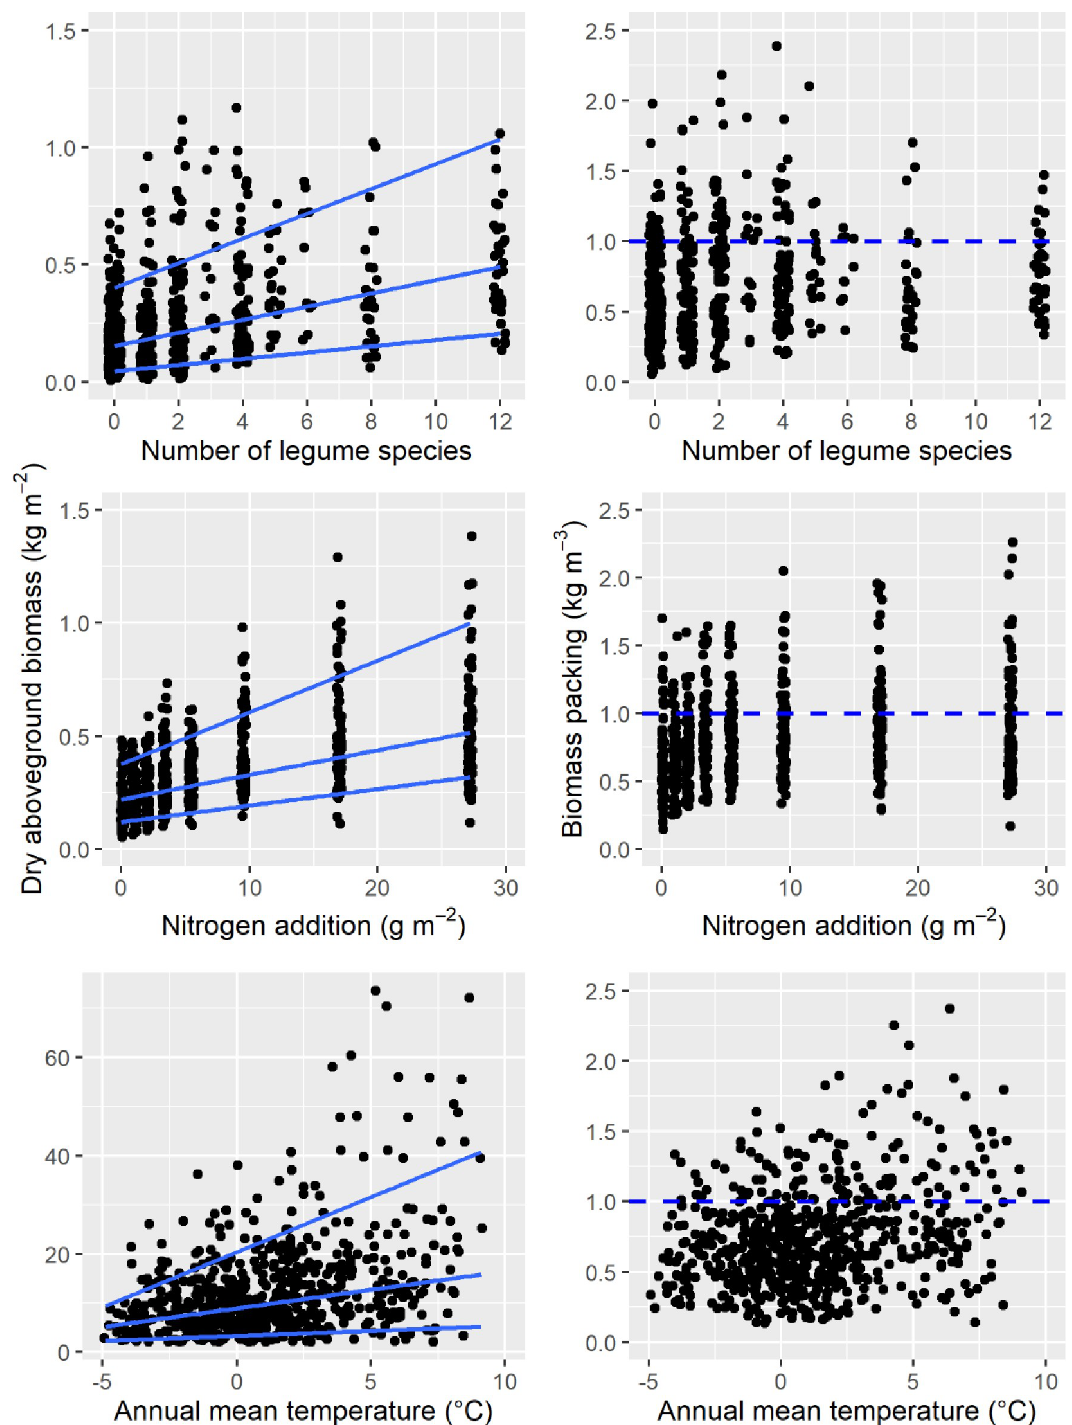
Fig 2. Effect of legume species richness (top panels), nitrogen addition (middle panels), and annual mean temperature (bottom panels) on the dry aboveground biomass (left panels) and the biomass packing (right panels) of Central Germany managed grasslands, Western US prairies and Canadian forests. Lines in left panels represent the 90 th and 10 th quantile regressions. Nitrogen addition, legume species richness, or annual temperature explained less than 7% of the variation in biomass packing through 50 th quantile (median) regression. The horizontal dashed line indicates the 1 kg m -3 reference value reported elsewhere [9].